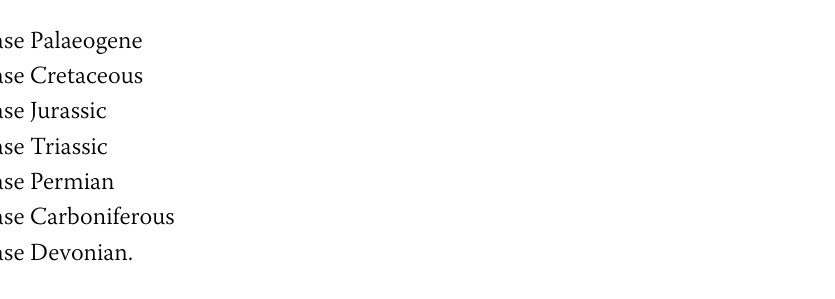
therefore the new grid generated represented the base of sedimentary rocks or top of the basement rocks, but not including areas where basement rocks were at surface/outcrop.